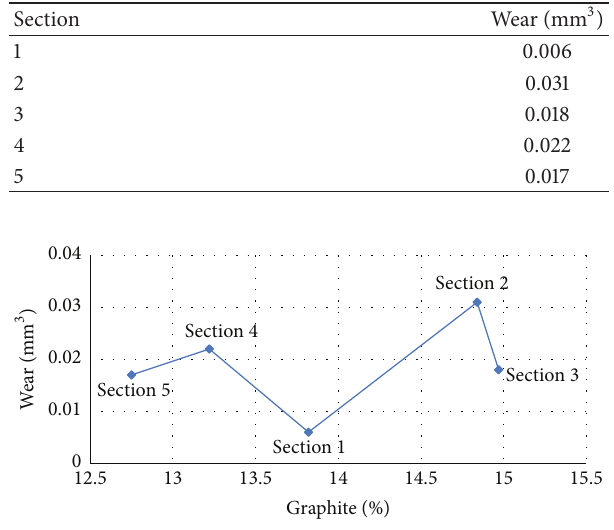
Figure 11: Graphic of the wear versus graphite